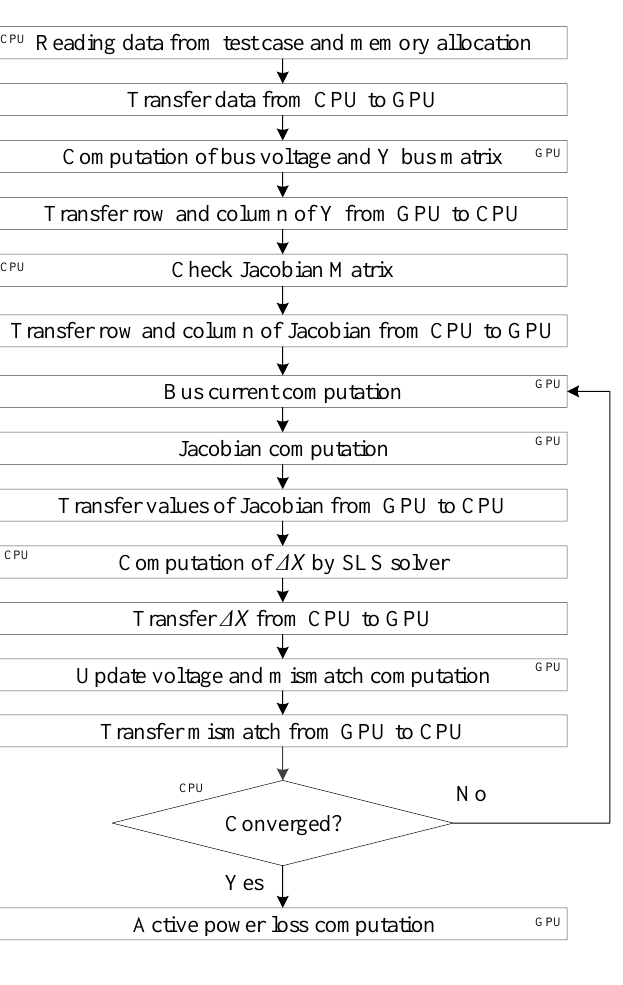
Figure 5. Hybrid CPU-GPU approach in